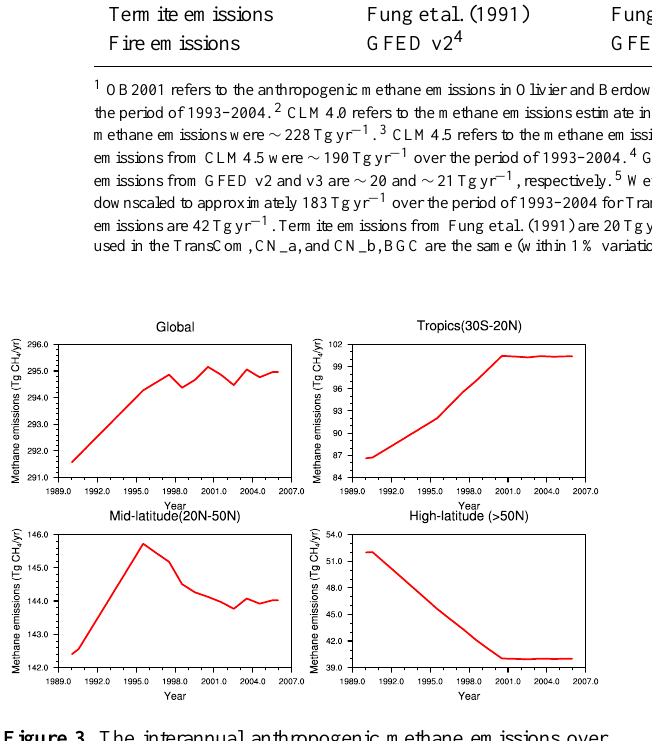
CLM4Me (cid:48) within the Community Land Model version